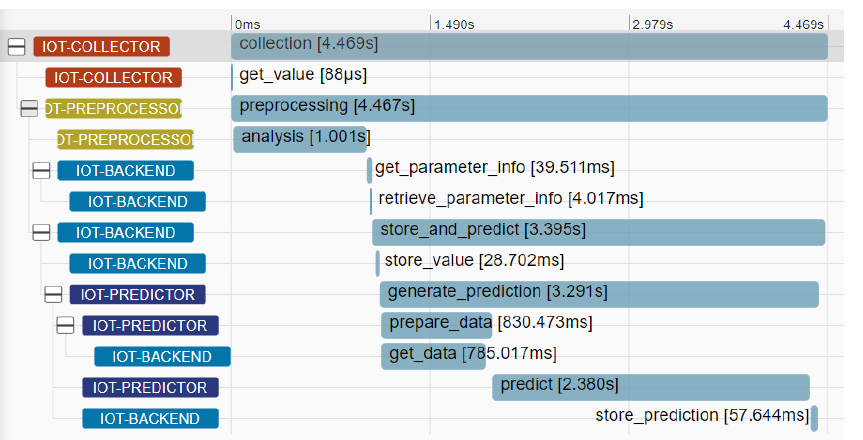
Figure 7. Trace 1 analysis in